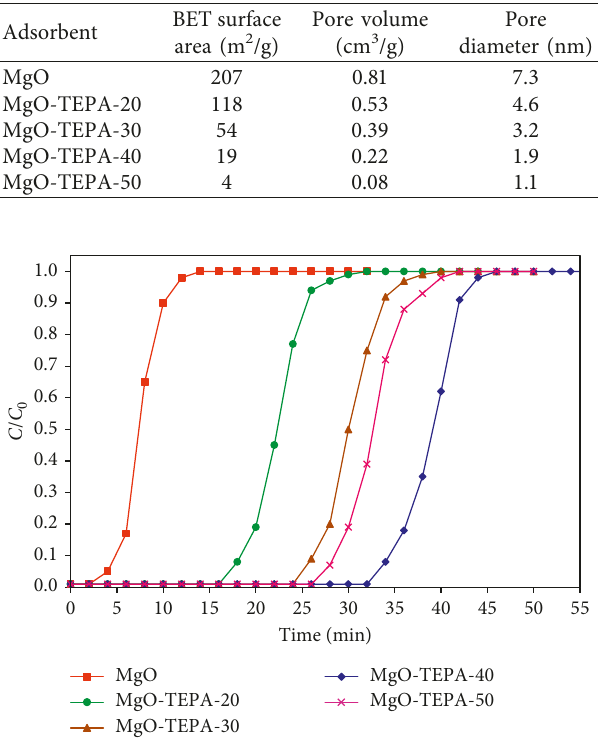
Figure 4: Breakthrough curves of MgO with different TEPA loadings.